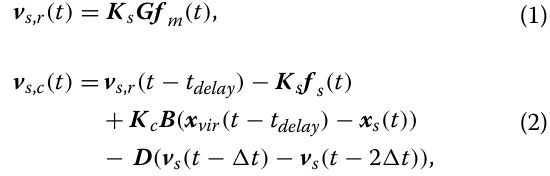
force generated at the slave arm, G is a diagonal scaling matrix between the force commanded by the master arm and the force the slave arm is expected to generate. In order for the slave arm to manipulate the massive pay- load, the force command f m given by the human oper- ator must be scaled up for the slave arm. The matrix G scales up the reference force. Substituting (1) into (2), the following equation is obtained: